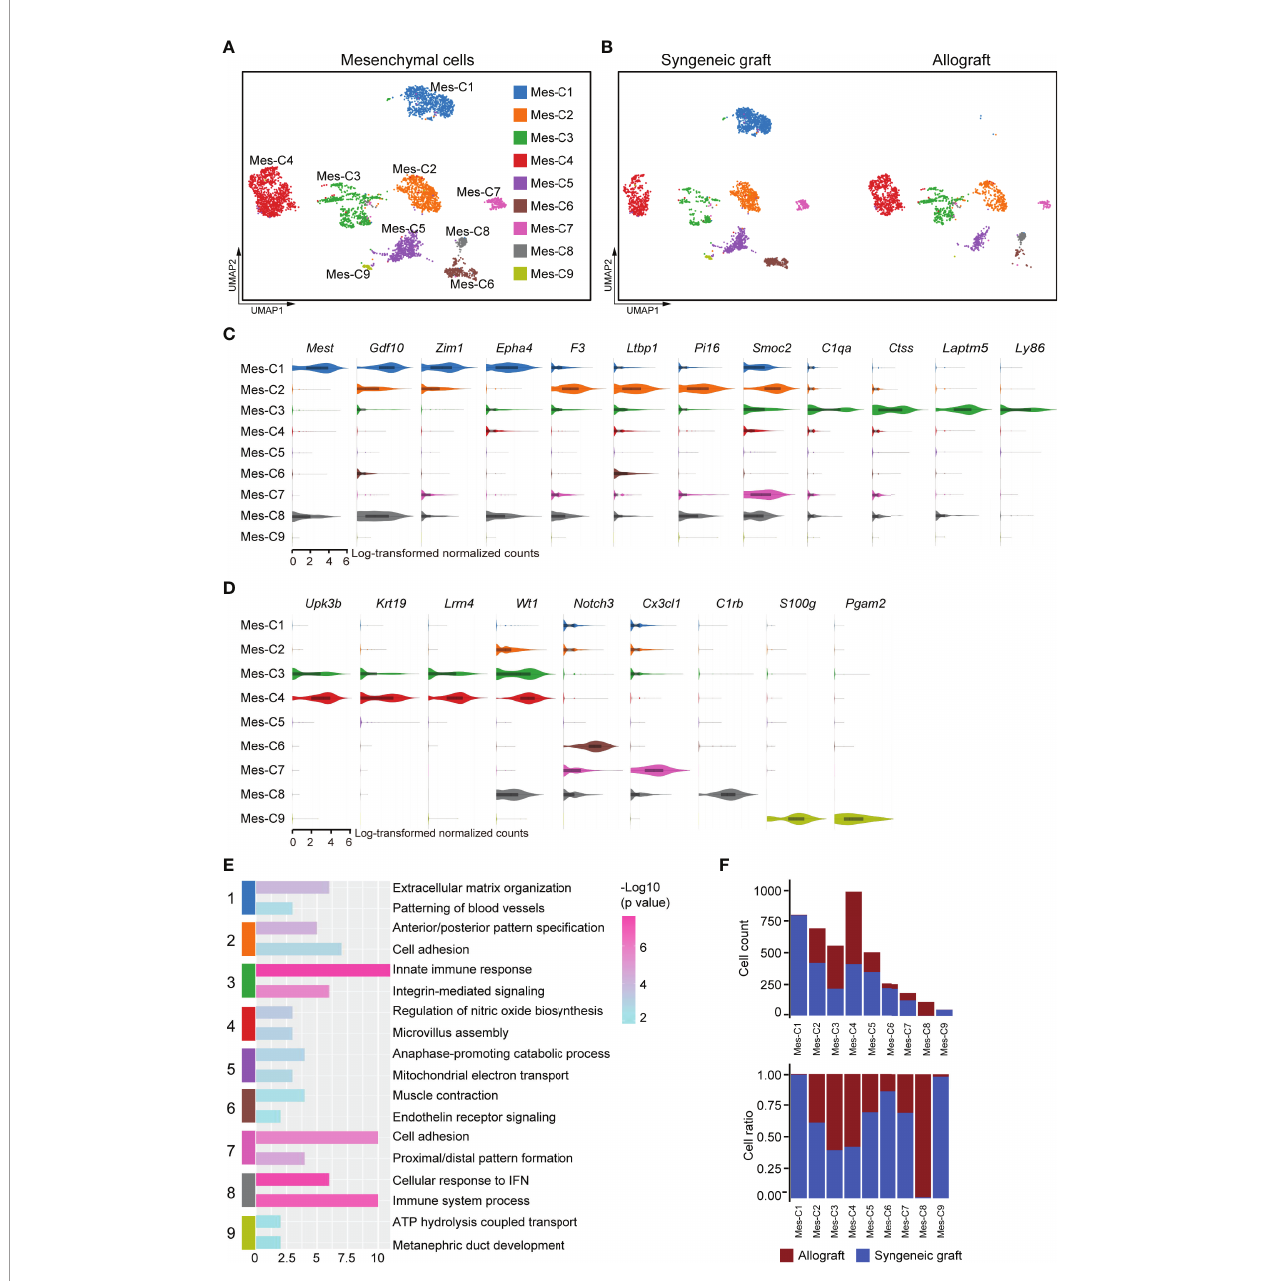
FIGURE 7 | Subclusters and molecular characteristics of mesenchymal cells 7 days post-transplantation. (A, B) UMAP visualization of mesenchymal cells, with each cell colorcoded for the associated cell subtype (A) and sample origin (B) . (C, D) Violin plots showing the smoothened expression distribution of the signature genes in subclusters C1-C3 (C) and C4-C9 (D) . (E) The top 2 gene ontology terms were based on marker genes in mesenchymal subclusters. (F) The number (upper panel) and a fraction (lower panel) of cells in the indicated mesenchymal cell